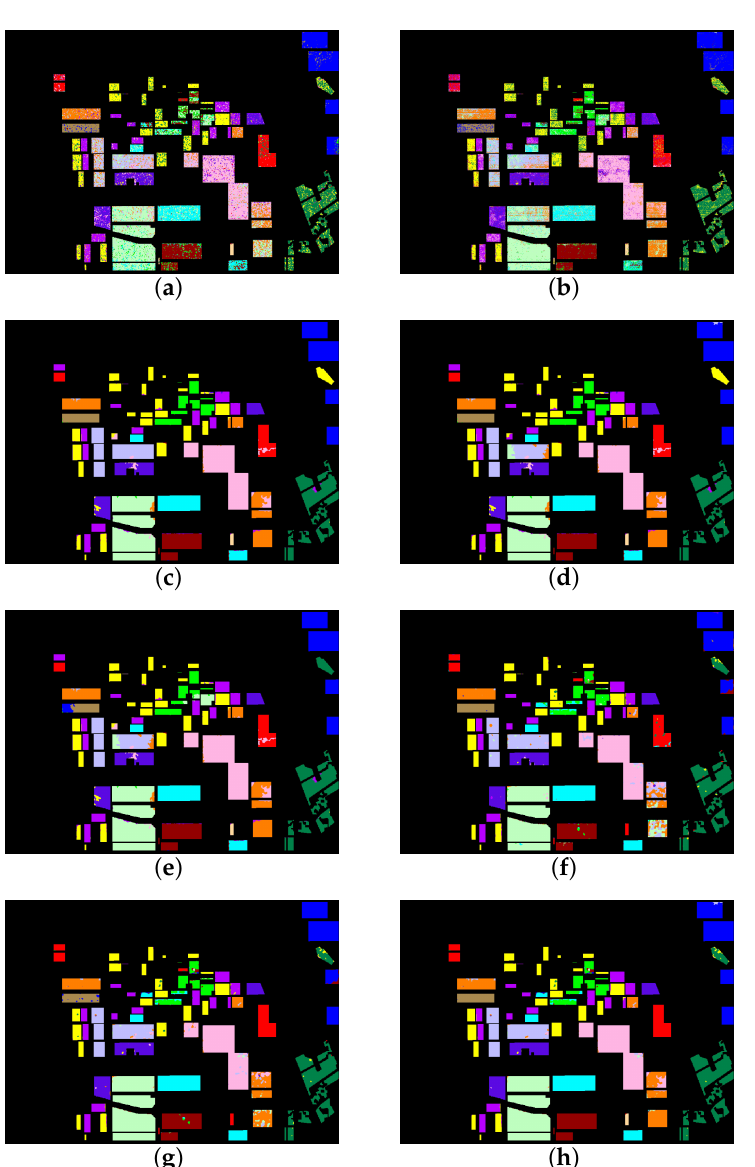
Figure 4. Classification results of Flevoland dataset overlaid ground truth. ( a ) SVM ( b ), LGBM ( c ),